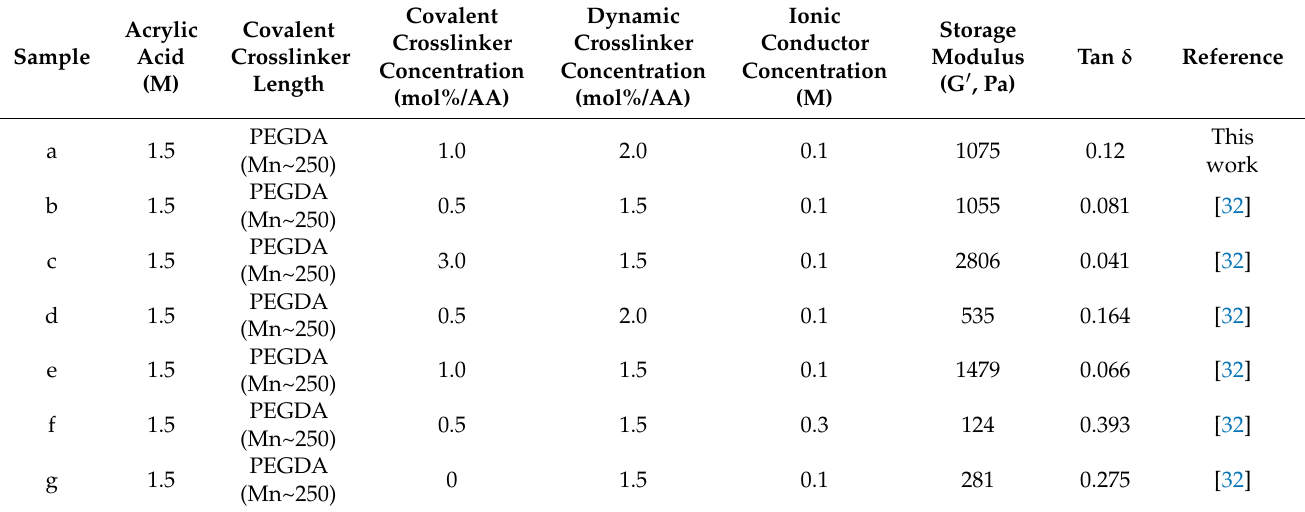
Table 1. Materials design and their rheological properties for the prepared PAA-based self-healing hydrogel in this work and previously reported hydrogels [32] (reproduced with permission from Ref. [32], Copyright (2021), Wiley-VCH Verlag GmbH & Co. KGaA, Weinheim,